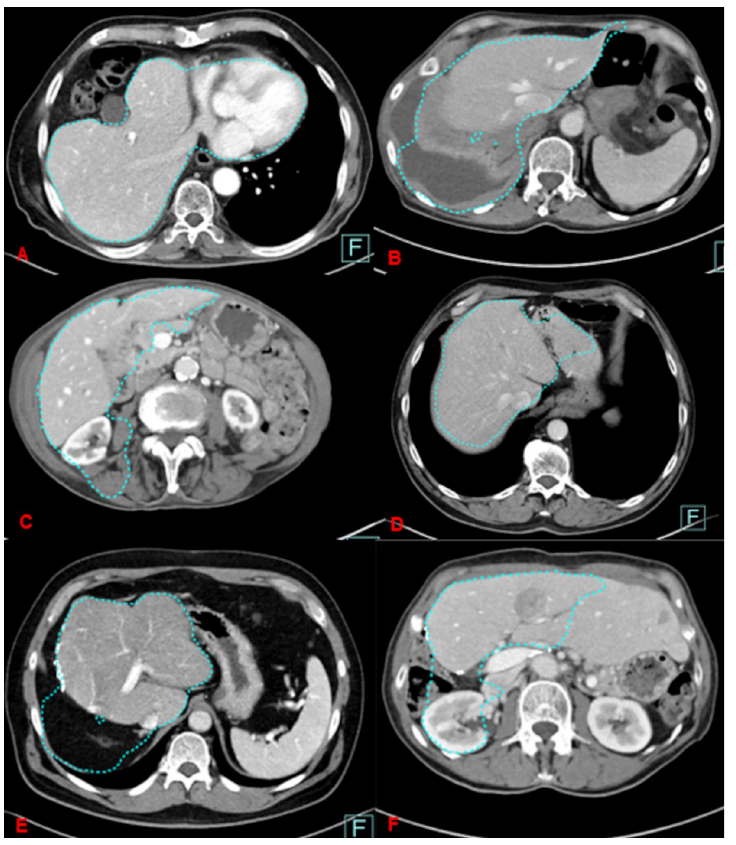
Fig 6. Pitfalls for enhanced image data sets.